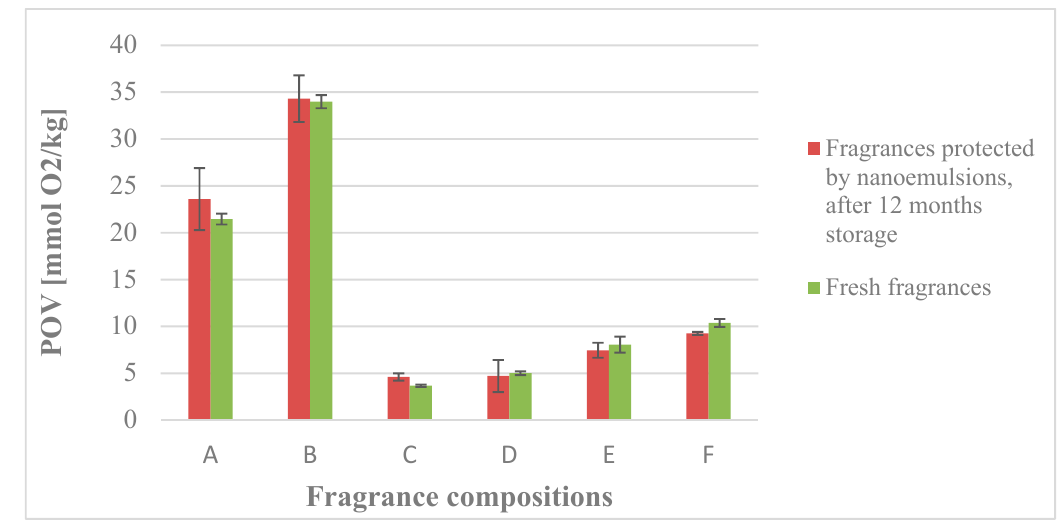
Figure 5. The peroxide values of the fragrances protected by nanoemulsions, after 12 months storage, and the fresh fragrance compositions (SD, n = 3).